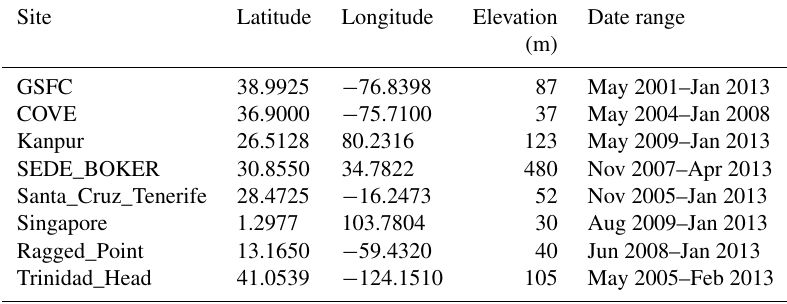
Table 3. AERONET and MPLNET sites and date ranges used for assessing cirrus and non-cirrus cloud